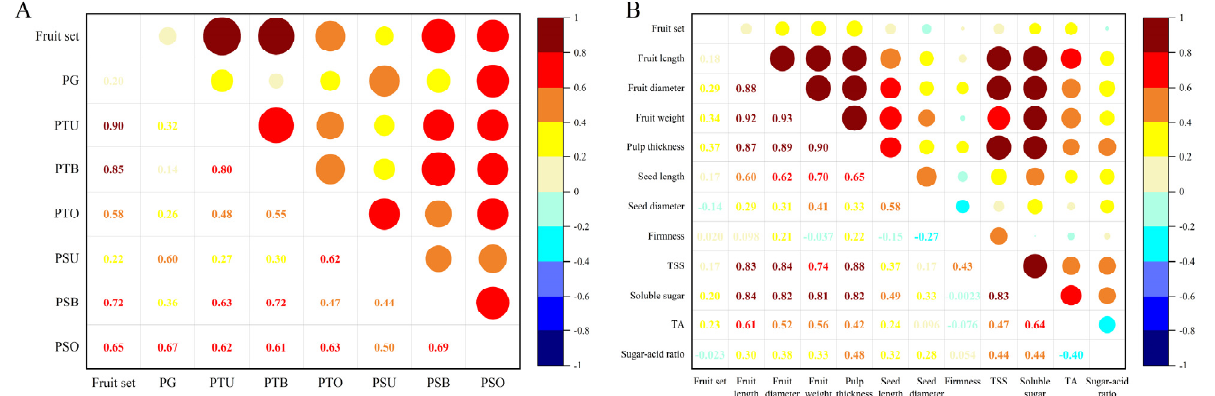
Figure 4. ( A ) Pearson’s correlation matrix between fruit set and reproductive parameters. PTU: number of pollen tubes at the upper third of style; PTB: number of pollen tubes at the base of style; PTO: number of pollen tubes penetrated to the ovary. PSU: percentage of pistils with pollen tubes at the upper third of style; PSB: percentage of pistils with pollen tubes at the base of style; PSO: the percentage of pistils with at least one pollen tube in the ovary. The values are statistically significant at p ≤ 0.05. ( B ) Pearson’s correlation matrix between fruit set and fruit characteristics.